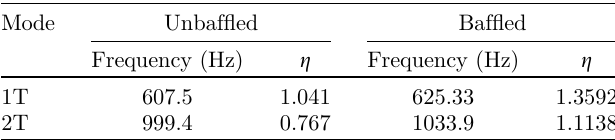
Table 2. Comparison of acoustic characteristics of unbaf fl ed and baf fl ed systems ( C y =